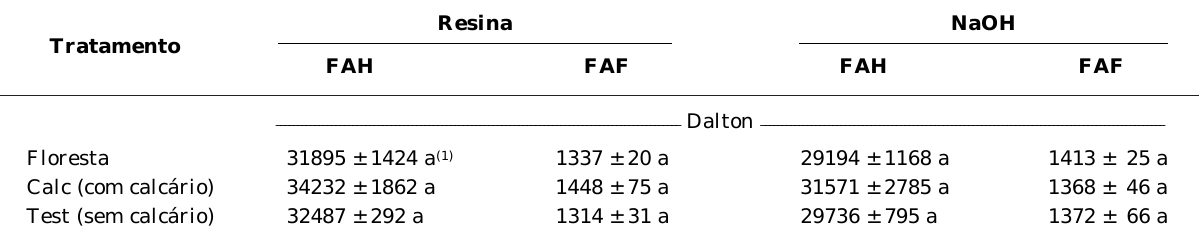
Quadro 4. Pesos moleculares estimados de FAH e FAF, obtidos via CETAE, sob influência do uso e manejo dos solos e do método de extração das substâncias